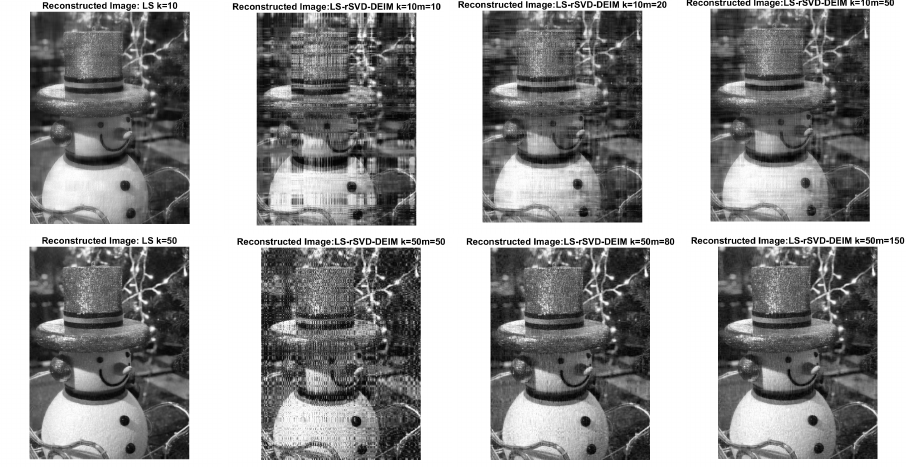
Figure 5. (Numerical Test 2) Reconstructed image from standard POD-LS with basis from SVD using dimension k = 10,50 and from the accelerated POD-LS with basis from rSVD using k = 10 with m = 10,20,50 and using k = 50 with m = 50,80,150.